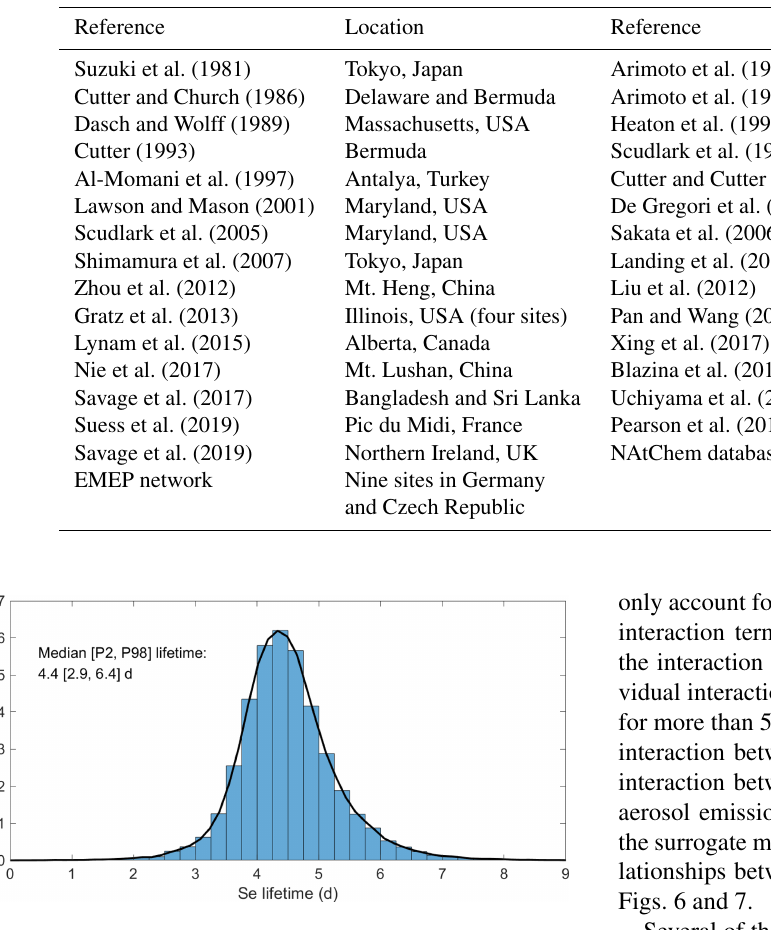
Figure 4. Distribution of the atmospheric Se lifetime, resampled from the surrogate model. Summary statistics (median, 2nd per- centile, and 98th percentile values) are listed on the